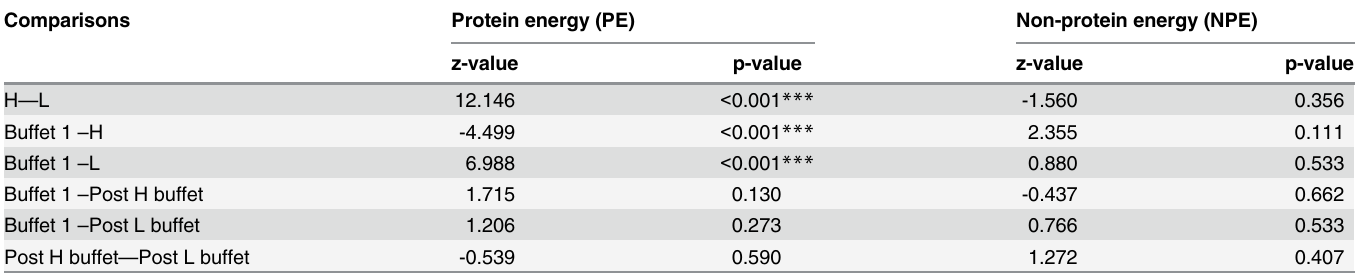
Table 5. Post-hoc test results of two linear mixed models (LMM) regarding adult moose individuals ’ daily protein energy intake (PE) and non-pro- tein energy intake (NPE) in the experiment (125 observation in each model).